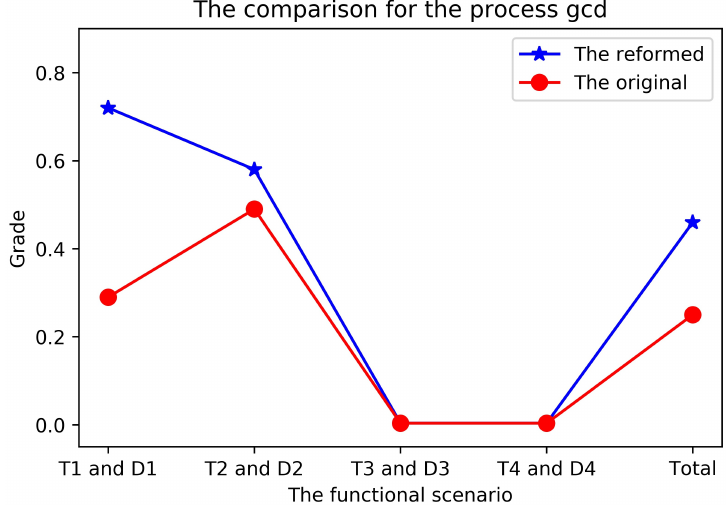
Figure 7. The grade of the reformed and